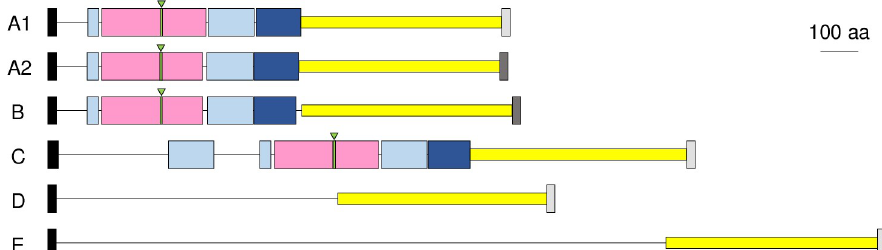
Fig 5. Domain arrangement of the Mfa5 protein in respective genotypes. Domain arrangements were designed based on the amino acid sequences deduced from the mfa5 gene of the representative strain of each genotype. The N- to C-terminal of the sequence is shown from left to right. The black box on the far-left side is the predicted signal peptide. Light and dark blue are Ig-like domains, called D2 and D3 domains in the paper published by Heidler et al . [36]. Genotype C has an additional Ig-like domain. The pink is the von Willebrand factor A domain, green (with a triangle) is ARM2, and gray at the C-terminal is the CTD. The CTD was classified into two types: light ( GAYVVSLQSPATSSNVRKVVVN ) and dark ( GAYIVHLQNAFTNDVHKVLVEY ) gray. Yellow is a common region among all genotypes. A1, ATCC 33277; A2, the first mfa5 ( mfa5-1 ) of W83; B, the first mfa5 ( mfa5-1 ) of SU60; C, WW5127; D, TDC60; E, the second mfa5 ( mfa5-2 ) of W83.